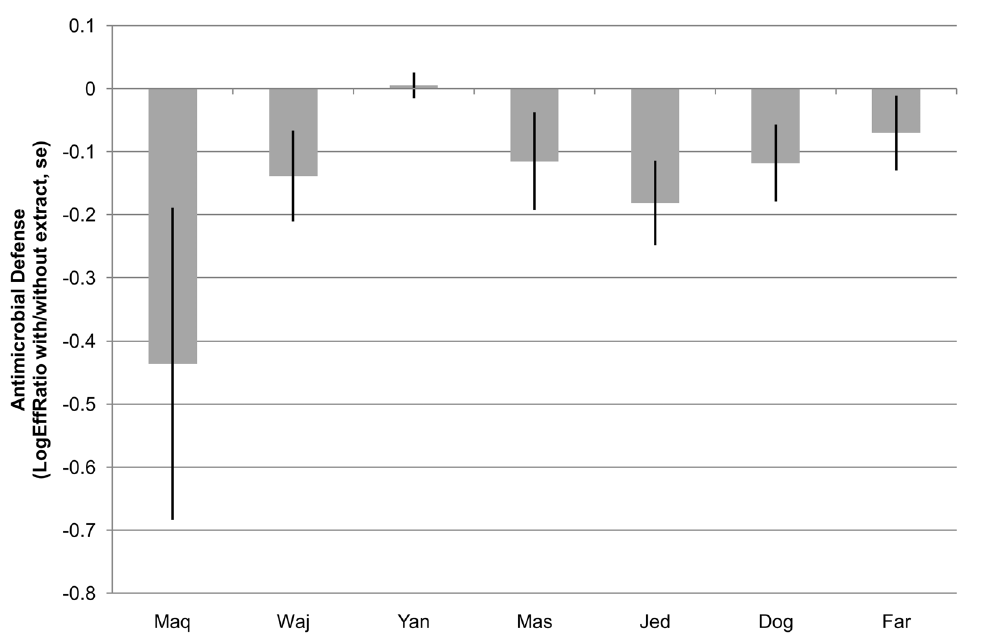
Fig. 4. Mean chemical antimicrofouling defense of P. verrucosa against three bacterial strains (averaged for the spring samplings in 2011 and 2012) along the Saudi Red Sea coast from north (Maq) to south (Far). Defense strength is expressed as Log Effect Ratio ( ¡ SE, see text): more negative values mean stronger repulsion of bacterial settlers by the coral holobiont surface